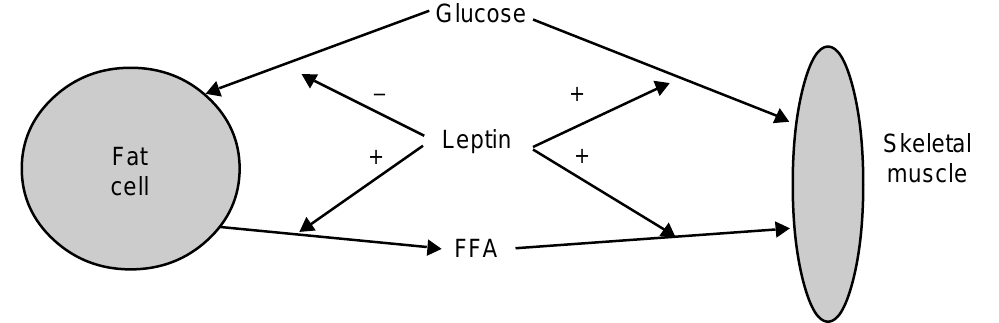
Figure 3 - Metabolic flux shifting hypothesis for leptin. + Stimu- lates, - inhibits. FFA = free fatty